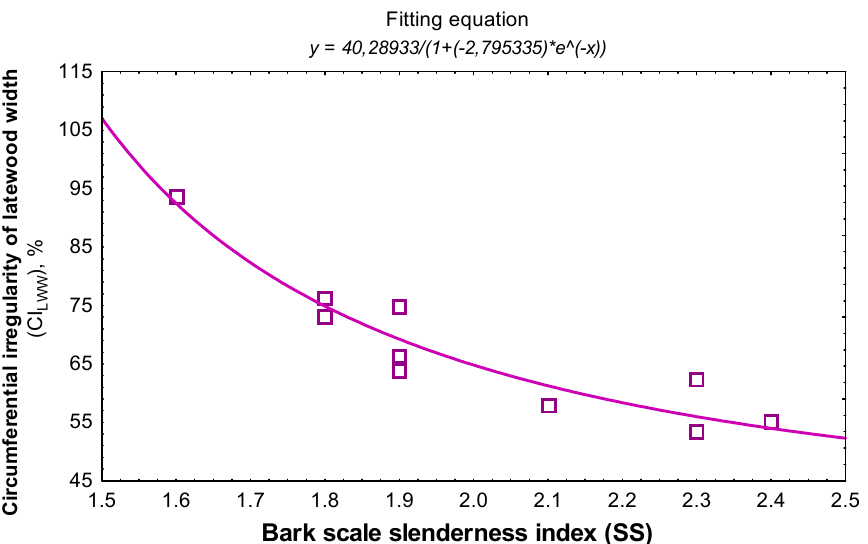
tree age or the diameter on the predictor is not statistically proven.